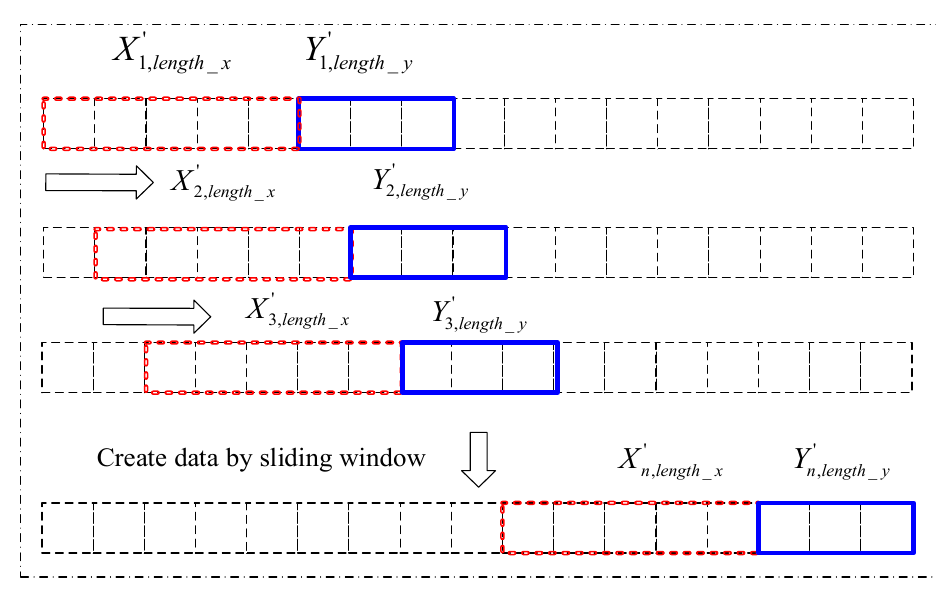
Figure 3. Single-scale sliding window.